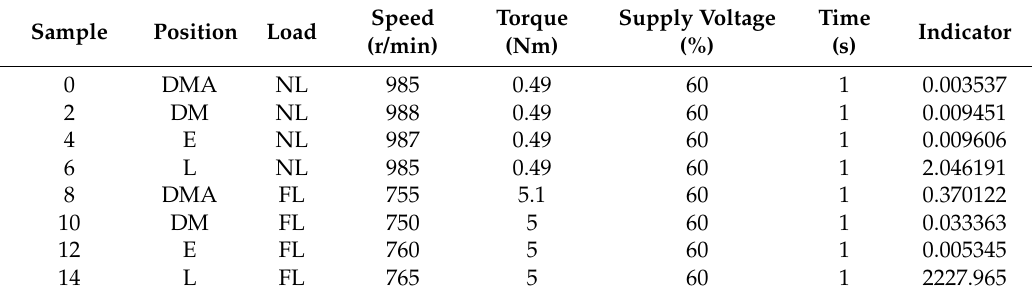
Table 11. Results of the indicator in the time domain, based on Equations (6)–(8), for the data of the experiments with the motor with one broken bar during startup.